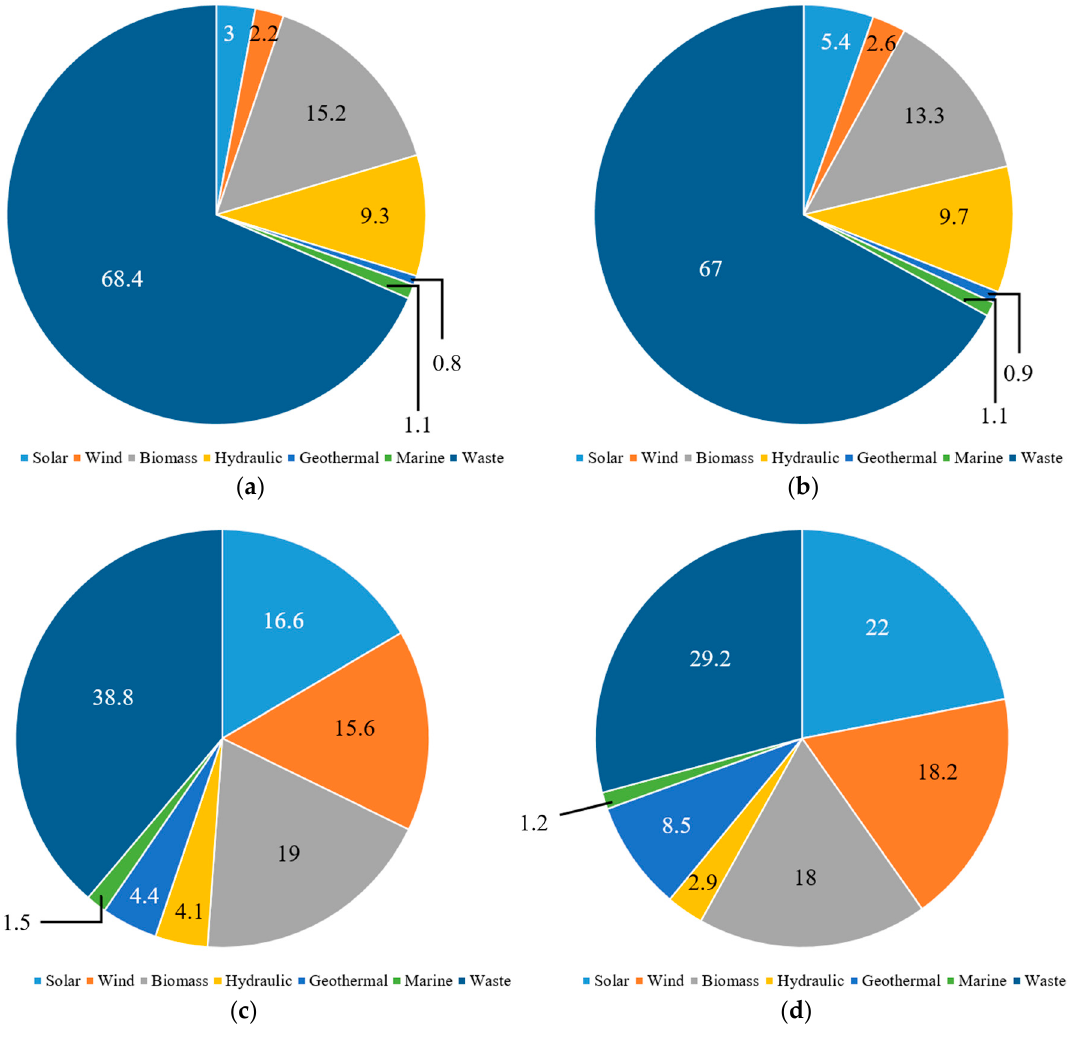
Figure 3. NRE supply composition ratio according to RPS (%) ( a ) 2012; ( b ) 2014; ( c ) 2020; ( d ) 2035 [20,21]. Table 1. Breakdown of wind data for